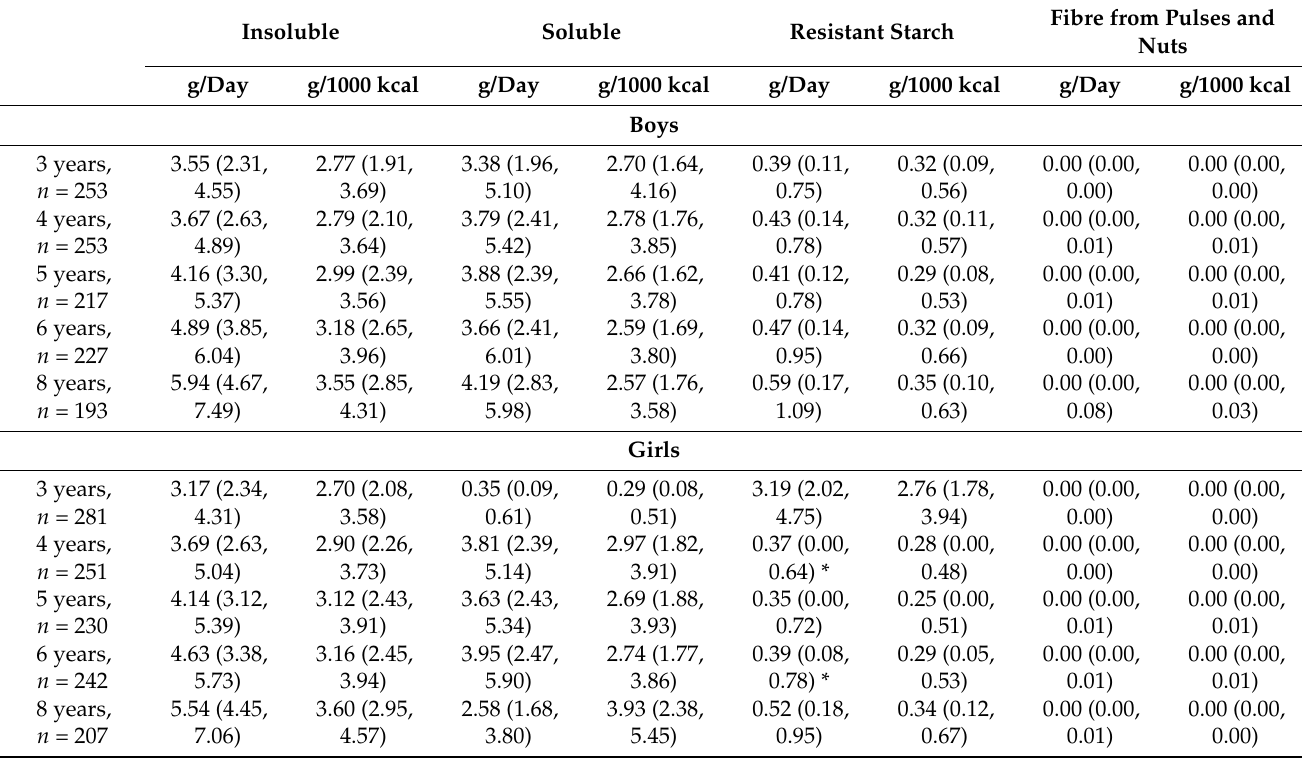
Table A2. Fibre intake by age according to food source in boys and girls. Insoluble Soluble Resistant Starch